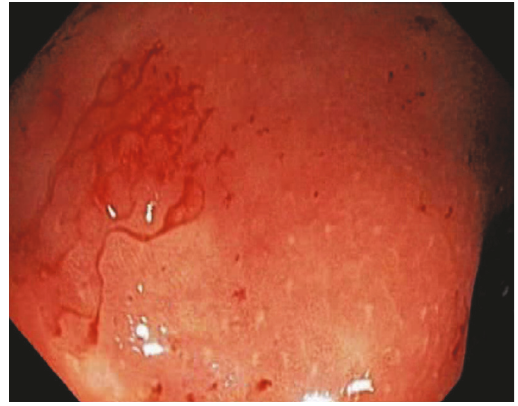
Figure 32: Endoscopic image of the cecum in a patient with ulcera- tive colitis. The colon mucosa is diffusely and continuously inflamed with small erosions or ulcerations, and petechial hemorrhage.